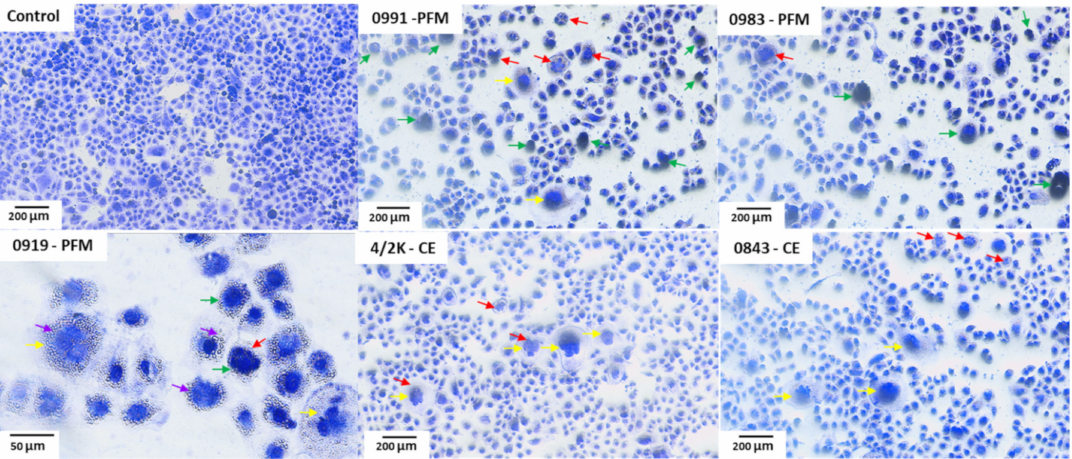
Figure 7. Images demonstrating morphology of Caco-2 cells after 24 h exposure to 10% ( v/v ) post- fermentation media (PFM) or cell extracts (CEs) of selected LAB stained with crystal violet. Observa- tions under inverted microscope (20 × and 40 × objectives) Nikon Ts2 with EMBOSS contrast (Nikon, Tokyo, Japan). Arrows: red (chromatin fragmentation); green (chromatin condensation); yellow (cell swelling); violet (vacuolisation of the